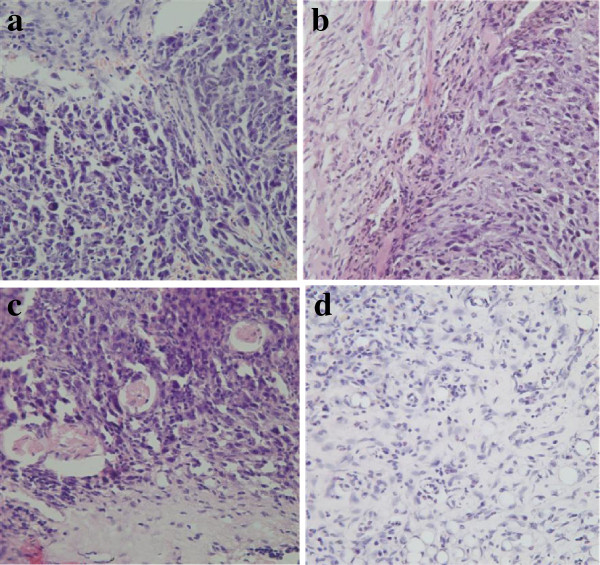
Tumor tissue in HEpathologyat 72 hours after treatment (HE×40). a: Control, b: 131I, c: His-IN, d: 131I-His-IN.